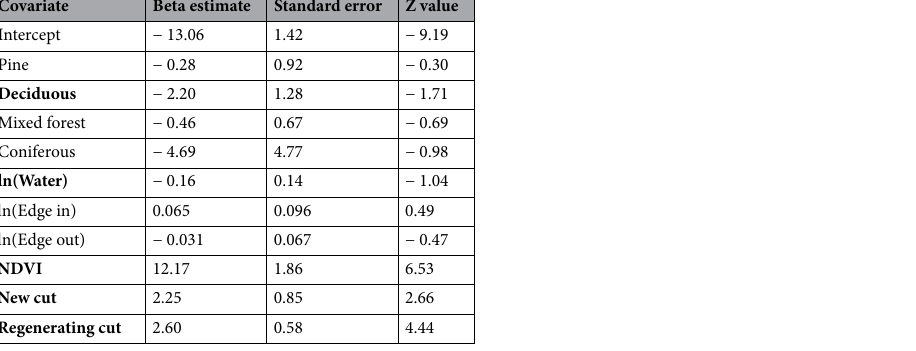
Table 3. Beta coefficient estimates for the top logistic regression model comparing habitat features to wolf kill- sites of moose in Prince George South, 2018–2020. Bolded terms indicate significance. ln() = log-transformed